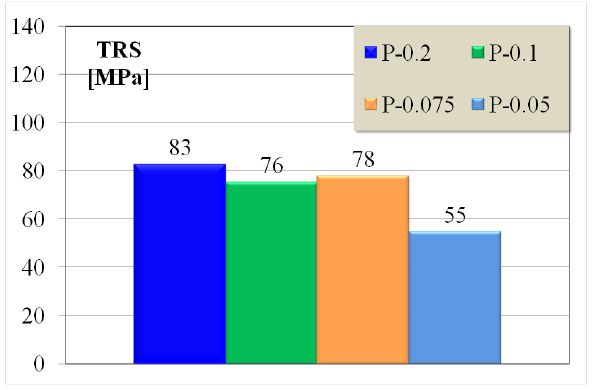
Figure 7: Mechanical strength of phenolic